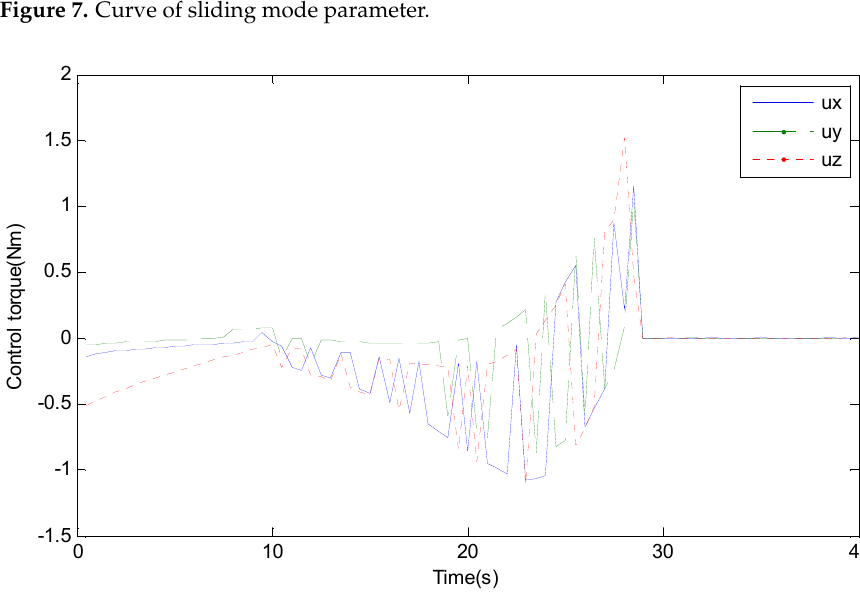
Figure 8. Curve of control torque.